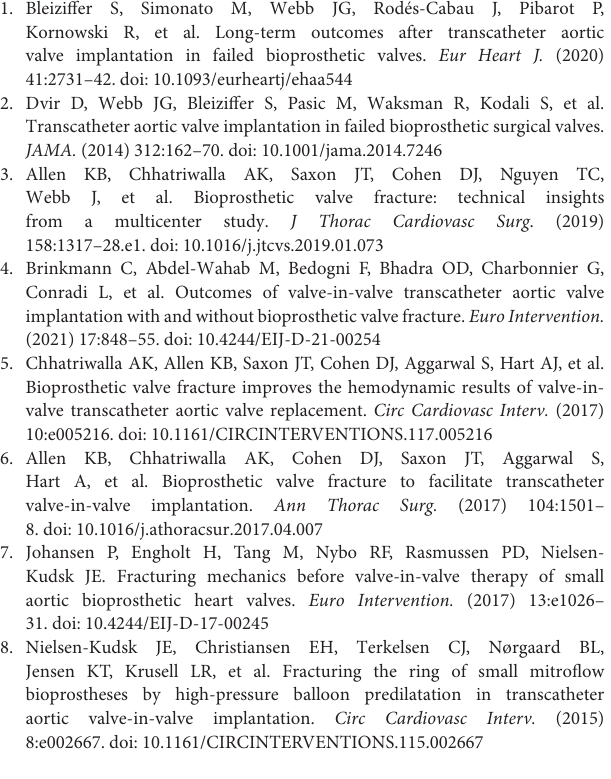
Supplementary Video 1 | Successful bioprosthetic valve